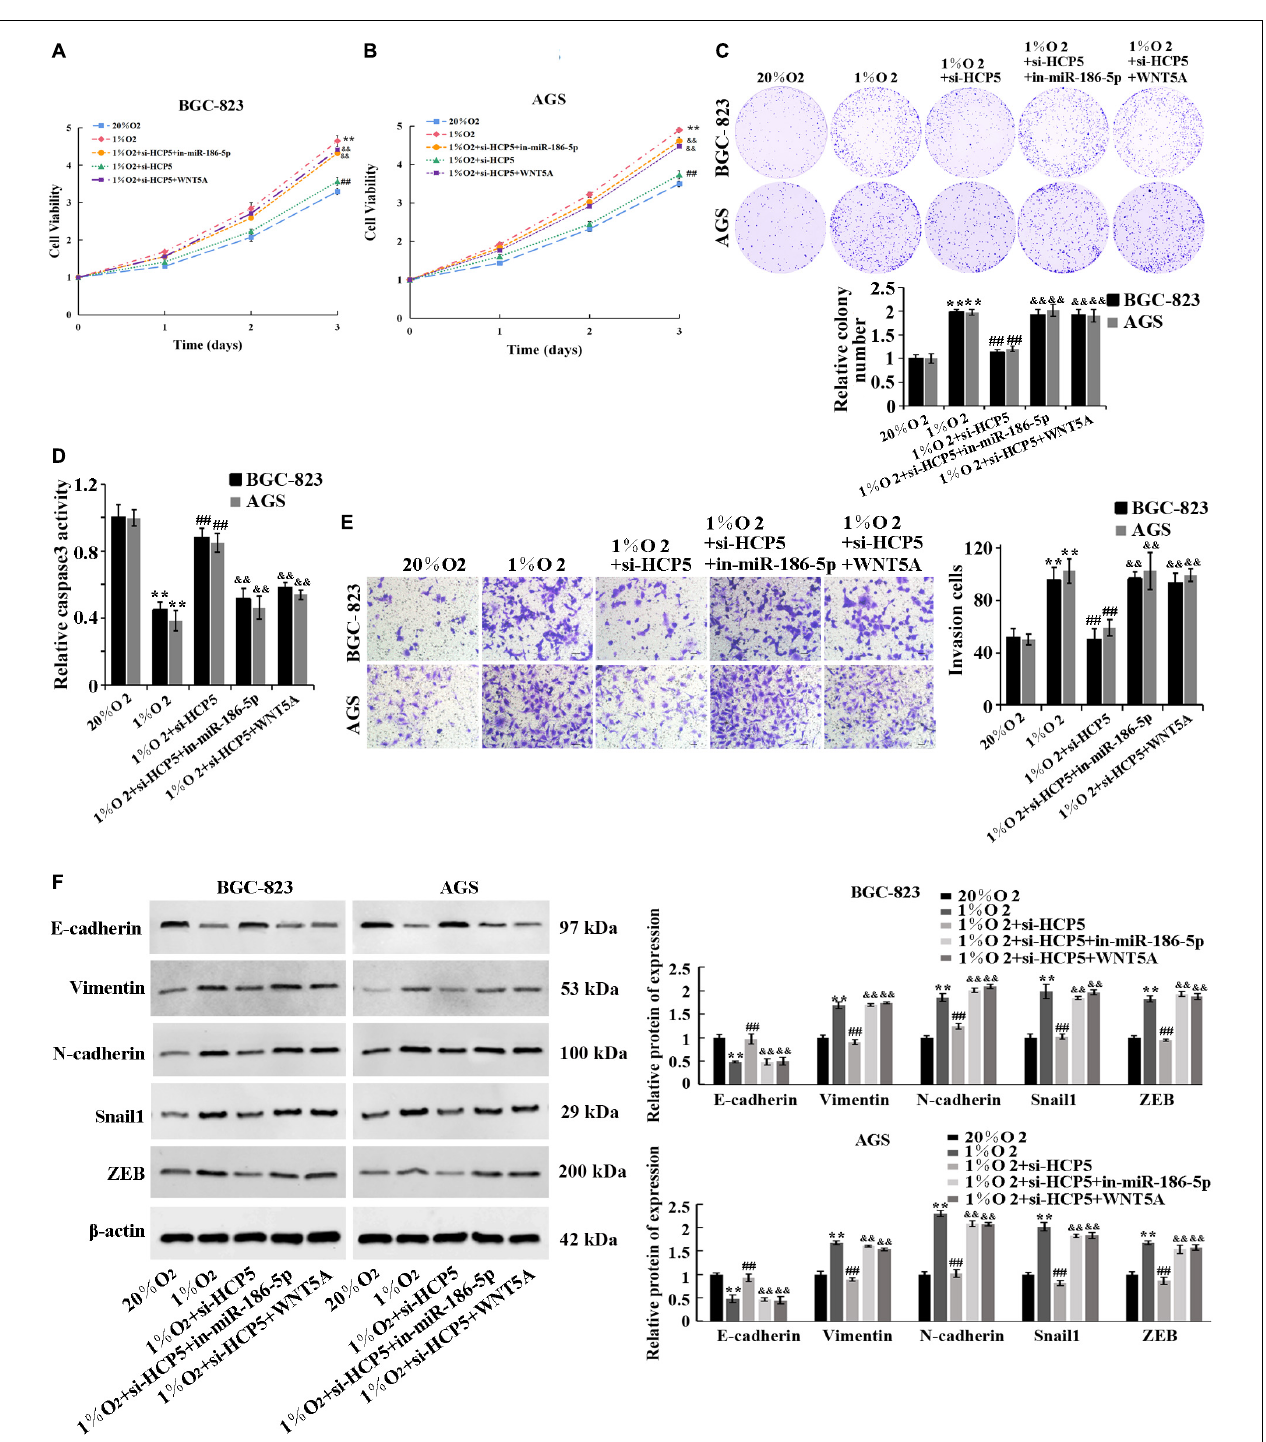
FIGURE 5 | Regulation of proliferation, invasion, and EMT process of hypoxia-treated gastric cancer cells by HCP5 through the miR-186-5p/WNT5A axis. (A,B) MTT-based detection of cell proliferation. (C) Colony formation assay-based detection of cell viability. (D) Caspase-3 activity in each group. (E) Transwell-based detection of cell invasion. (F) Western blot-based detection of protein expression of E-cadherin, Vimentin, N-cadherin, Snail1, and ZEB. ** p < 0.01 vs. 20% O 2 group; ## p < 0.01 vs. 1% O 2 group; && p < 0.01 vs. 1% O 2 + si-HCP5 group.